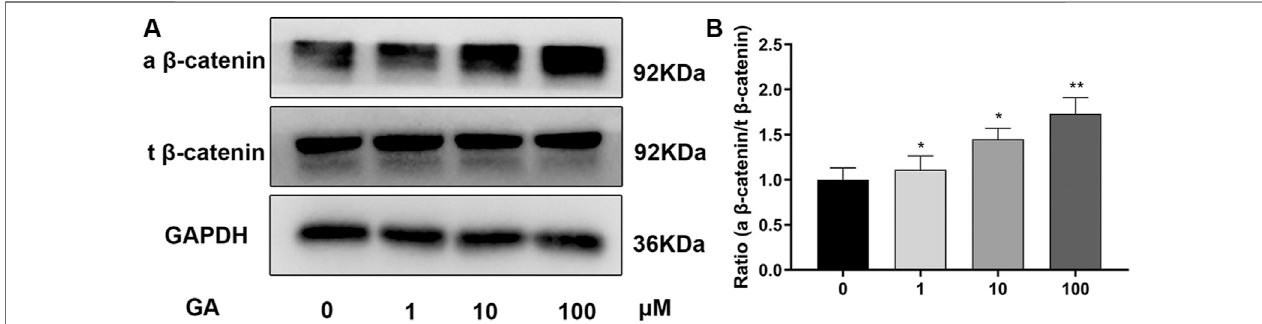
FIGURE3| GApromotesosteogenicdifferentiationofhMSCspartlyviatheWnt/ β -cateninsignalingpathway. (A) Relativeproteinexpressionlevelsofcomponents ofdifferentsignaling pathwayswereassessed bywestern blotting. hBMSCs wereincubated withdifferentconcentrationsofGAduring osteogenic differentiation onday 3. The protein expression levels were normalized relative to that of GAPDH protein. (B) the quantitation of ratio (a beta-catenin/t beta-catenin) to re fl ect the activation of Wnt/beta-catenin signaling pathway. All tests were performed in triplicate. Data are expressed as means ± SD. ** p < 0.01 compared to the control group.